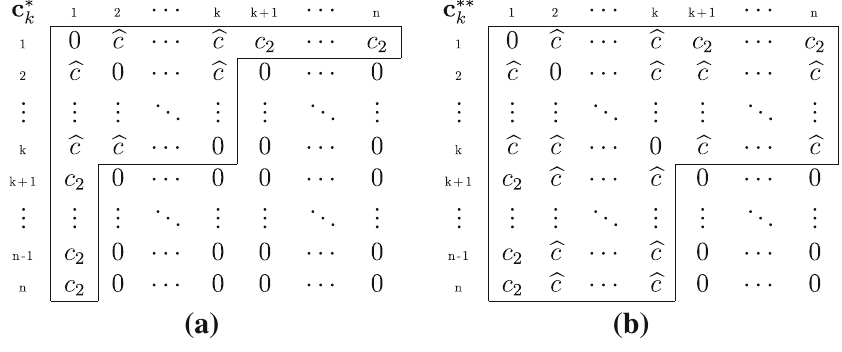
Fig. 4 Two-level investment matrices of DNSG -networks c ∗ k and c ∗∗